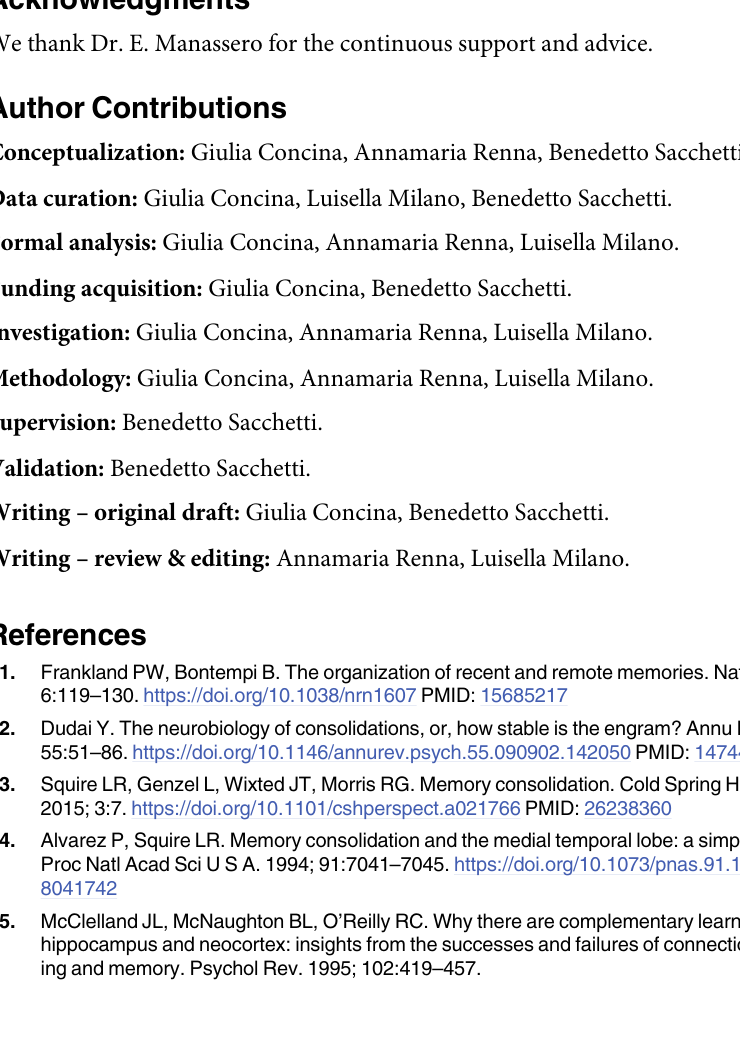
S3 Data. Raw data of Fig 3. (XLSX) S4 Data. Raw data of Fig 4. (XLSX) S5 Data. Raw data of Fig 5. (XLSX) S6 Data. Raw data of Fig 6. (XLSX) S1 Statistical Test Data. Statistical tests employed in the experiments. S1 Supporting Figure Data. Raw data of S1–S3 Figs. (XLSX) S1 Table. Number of rats employed in each group during each experimental replication.